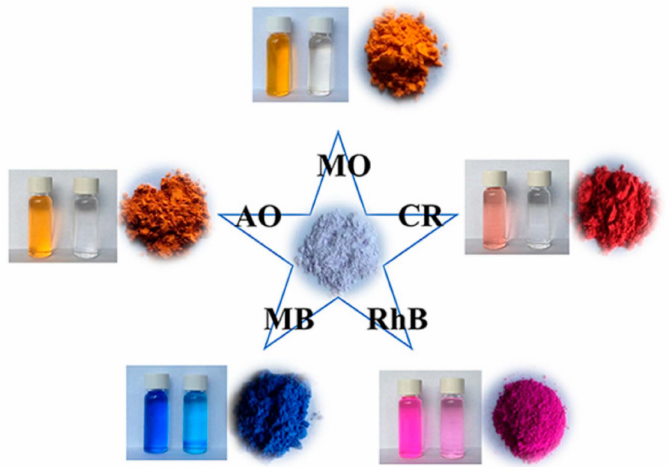
Figure 12. Schematic diagram of adsorption effect of SCNU-Z1-Cl on five organic dyes. Reprinted with permission from Ref. [116]. Copyright 2019, American Chemical